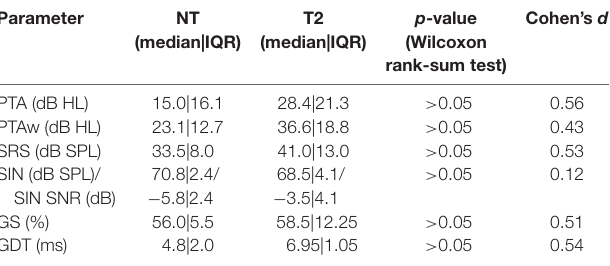
TABLE 2 | Comparison of NT participants with tinnitus patients having Tinnitus Handicap Inventory (THI) scores worse than “slight” (T2